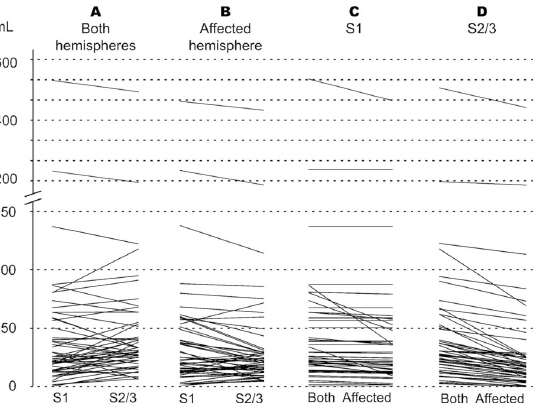
Fig 1. Paired comparisons of the automatically calculated ischemic core volumes (mL) for each patient measured using setting 1 (S1) versus settings 2 or 3 (S2/S3) using data from both hemispheres (A), for S1 versus S2/S3 using data from the affected hemisphere only (B); for S1 using data from the bilateral versus ipsilateral hemispheres (C), and for S2/S3 using data from the bilateral versus ipsilateral hemispheres (D). https://doi.org/10.1371/journal.pone.0249772.g001 P < 0.01) and non-significant difference between S1 and S2 (P = 0.316). When the analysis was